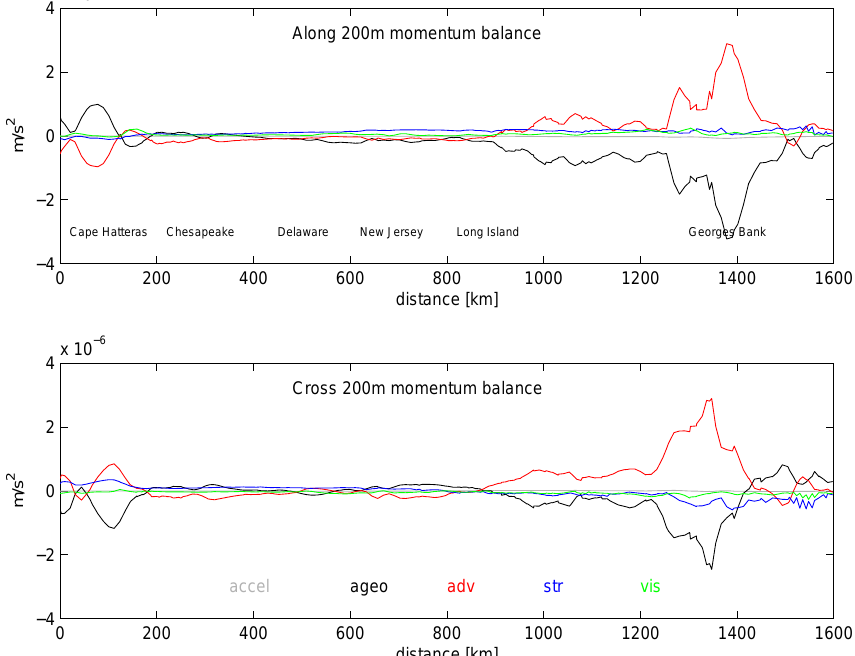
Figure 12. Mean momentum term-by-term balances in along (upper) and across (lower) the 200m isobath directions. Momentum terms in the figure represent time rate of change (accel), ageostrophic circulation (ageo), advection (adv), surface and bottom stress (str), and horizontal viscosity